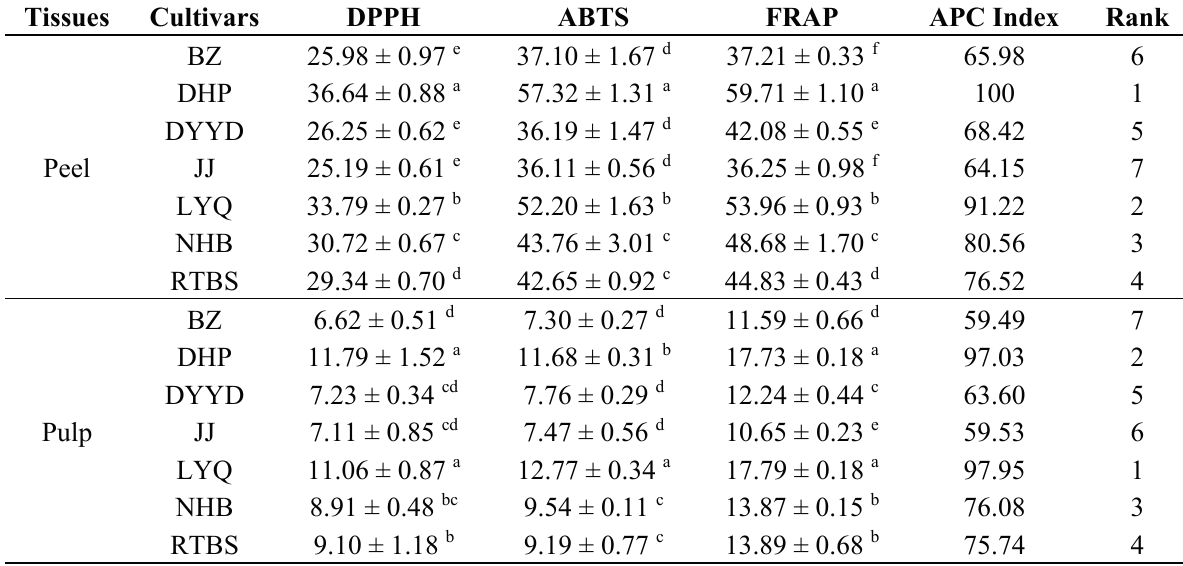
Table 5. Antioxidant capacities of peel and pulp extracts of seven loquat cultivars (mg TEAC/g